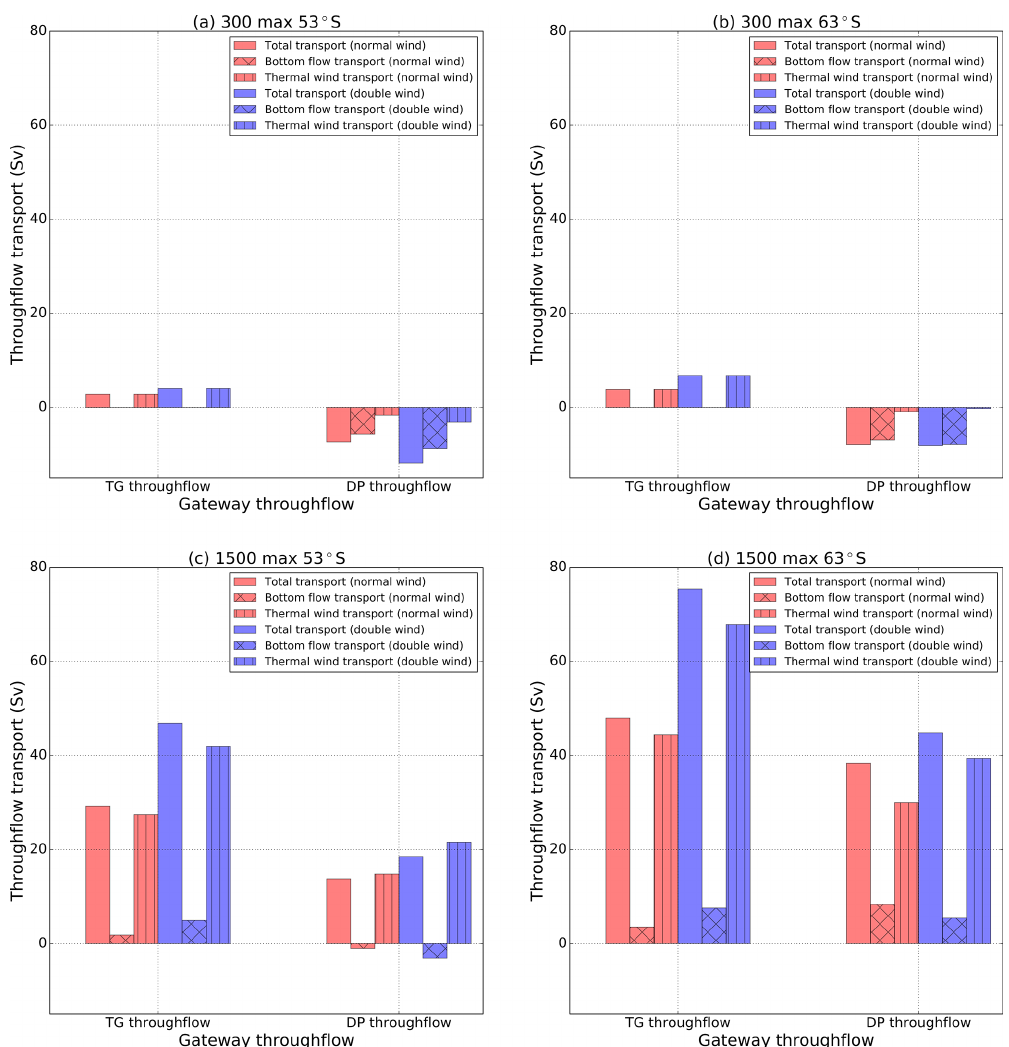
Figure 5. The contrast of TG (red) and DP (blue) throughflow volume transport in normal-strength and double-strength wind stress experi- ments. The total transport ( T total ) is decomposed into bottom flow transport ( T b ) and thermal wind transport ( T tw ).